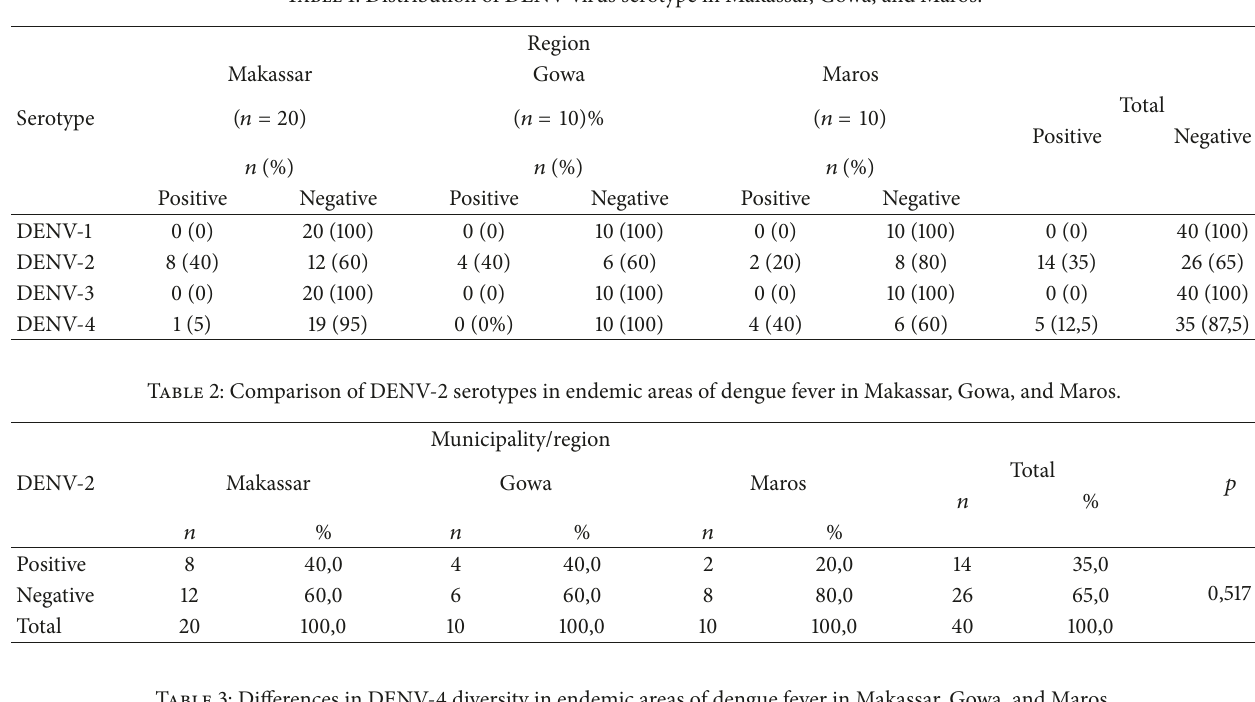
Table 3: Differences in DENV-4 diversity in endemic areas of dengue fever in Makassar, Gowa, and Maros.